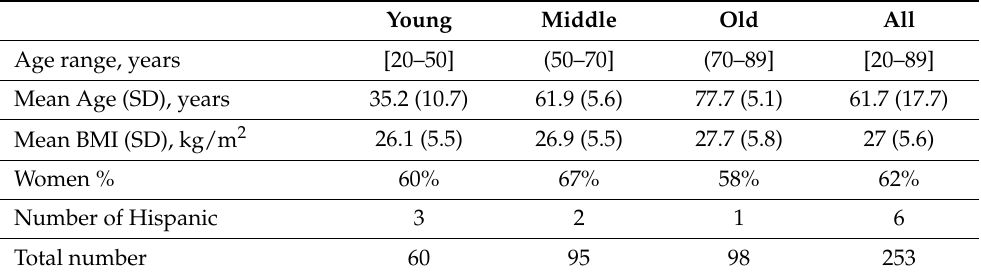
Table 2. Participants descriptive characteristics by age group.